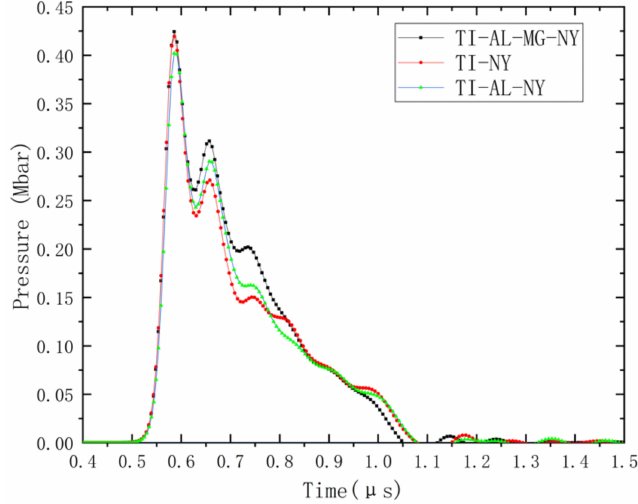
Figure 6. The change in the projectile-shock-wave amplitude corresponding to the three protective screen materials.